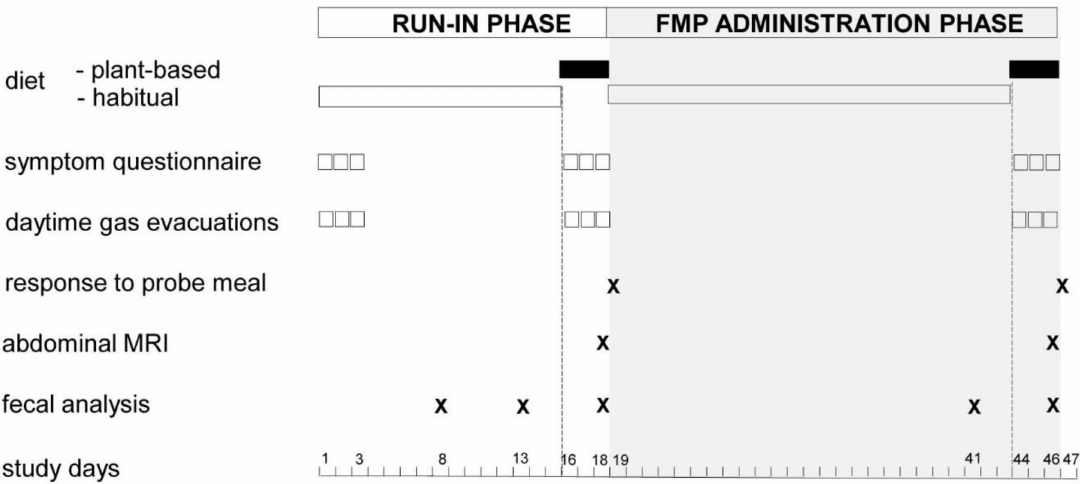
Figure 1. Study design. FMP: fermented milk product. Abdominal MRI scheduled in half of the participants. During the study, participants were instructed to consume their habitual diet except during the last 3 days of the run-in phase (days 16–18) and the administration phase (days 44–46) when a mostly plant-based diet (see below) was administered. Participants were not allowed to consume any fermented dairy products (with or without probiotics) or any tablets, pills, or food supplements containing pre- or probiotics other than those provided during the study. The food items of the plant-based diet and the fermented milk product were provided by the